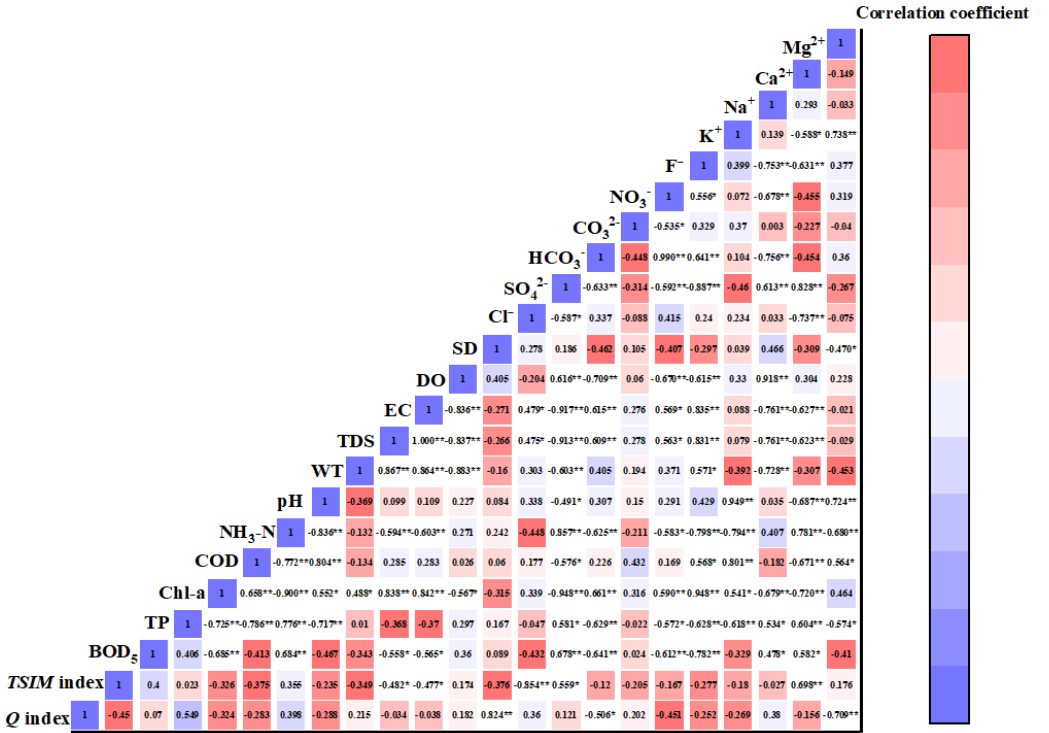
Figure 7. Pearson correlation analysis of environmental factors and Q index and TMIS index in Nanhai Lake. Notes: ** Indicates that the correlation is significant at the 0.01 level (double tails), * indicates that the correlation is significant at the 0.05 level (double